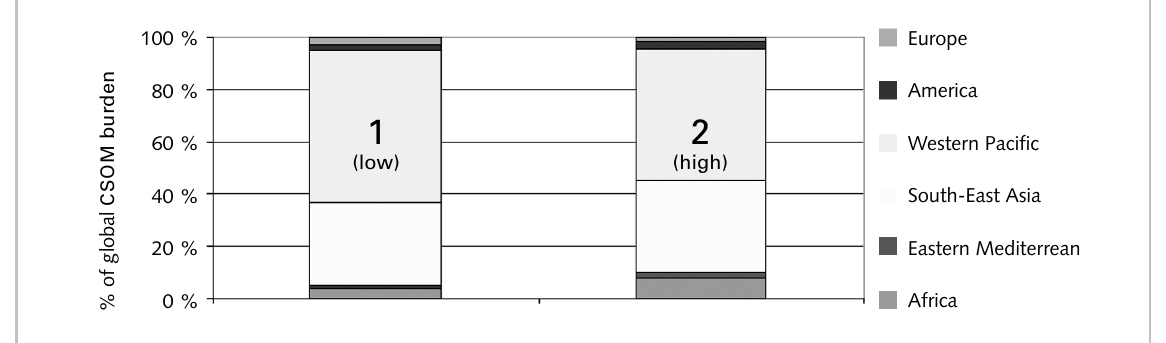
Fig. 2. Regional contributions to the global CSOM using low (column 1) and high (column 2) prevalence